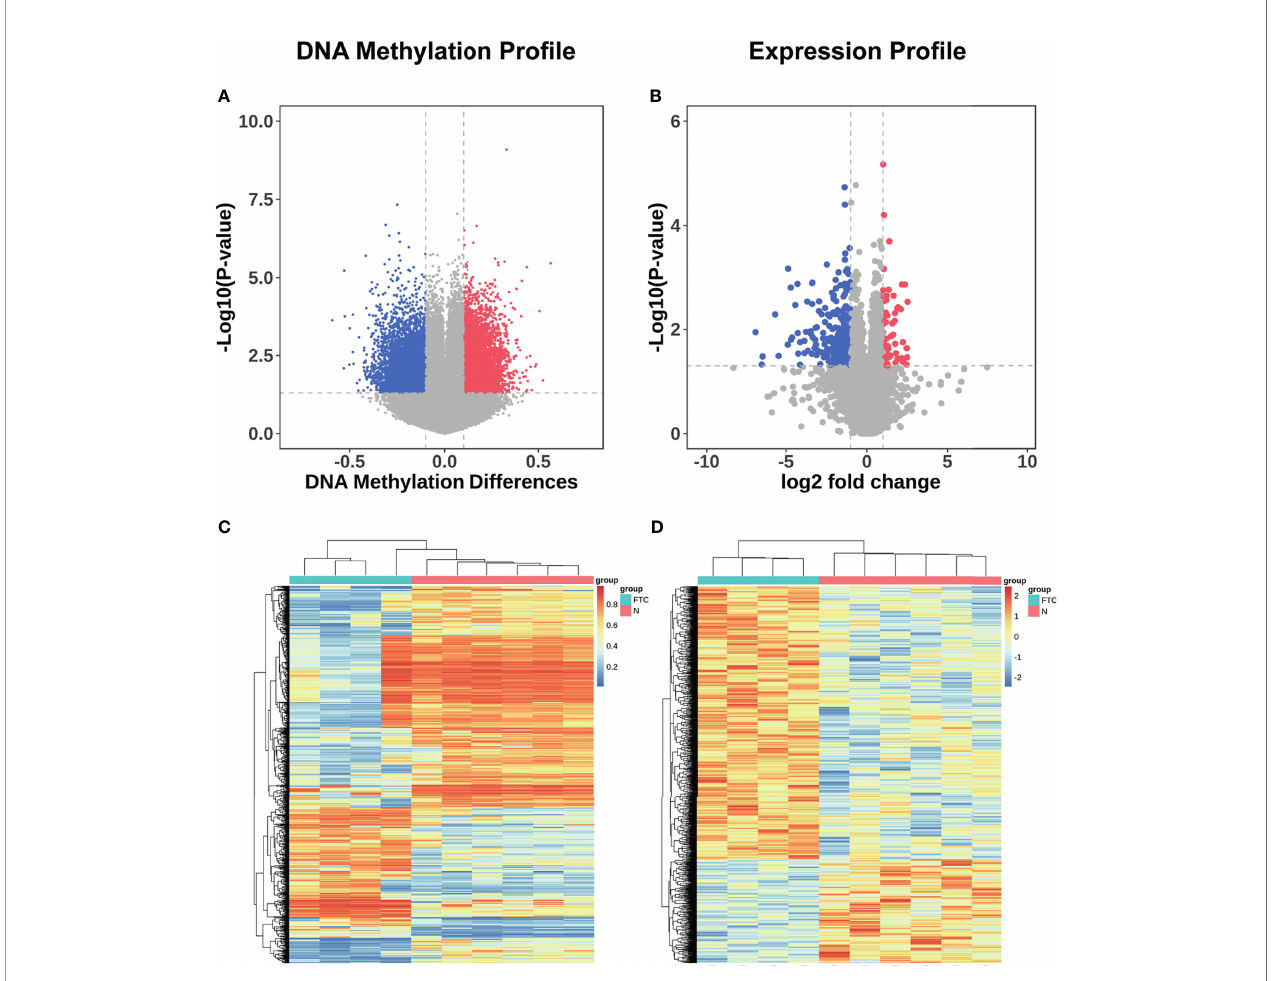
FIGURE 2 | DNA methylation and mRNA expression pro fi le of the discovery set. (A) Volcano plots showing differentially methylated sites in discovery datasets. Sites with △ b value > 0.1 and P value < 0.05 were de fi ned as signi fi cantly hypermethylated methylation sites, which were showed in red; meanwhile, those with adjusted P value < 0.05 and △ b value < -0.1 were de fi ned as signi fi cantly hypomethylated methylation sites, which were showed in blue. The other miRNAs were showed in grey. (B) Volcano plots showing differentially expressed mRNAs in discovery datasets. mRNAs with adjusted P value < 0.05 and log2FC > 1 were de fi ned as signi fi cantly overexpressed mRNAs, which were showed in red; meanwhile, those with adjusted P value < 0.05 and log2FC < -1 were de fi ned as signi fi cantly under- expressed mRNAs, which were showed in blue. The other mRNAs were showed in grey. (C) Heatmap showing a promising result of the hierarchical clustering analysis using differentially methylated sites to distinguish different samples in discovery dataset. (D) Heatmap showing a promising result of the hierarchical clustering analysis using differentially expressed genes to distinguish different samples in discovery